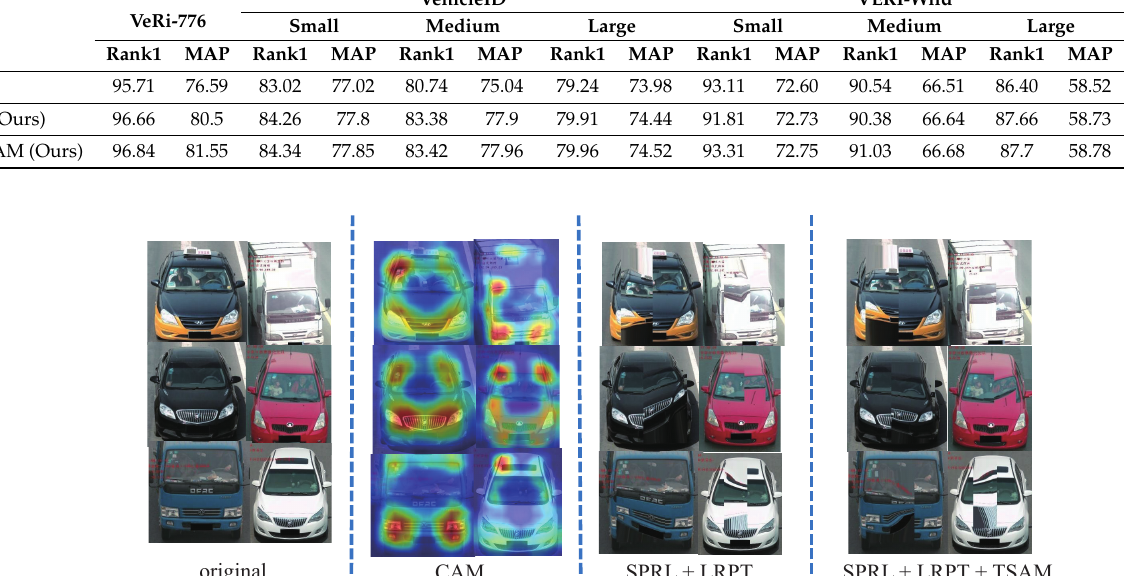
Figure 8. Augmented results with various modules. Col 1: Input images. Col 2: Heatmap using Relation-Aware Attention. Col 3: Augmented results using SPRL + LRPT. Col 4: Augmented results using SPRL + LRPT +